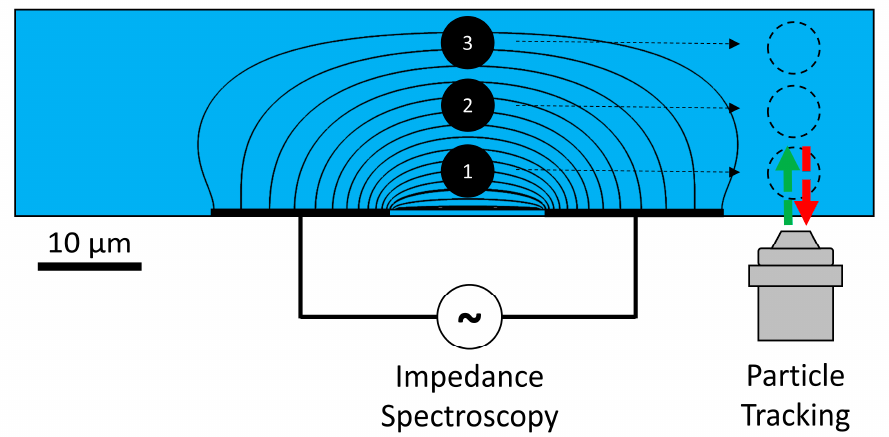
Figure 1. Coplanar electrode setup illustrating the inhomogeneous electric field. Passing particles in laminar flow at the bottom, middle, and top of the channel will all result in different impedance changes, owing to the inhomogeneity. Independent optical verification of the particle height is performed using general defocusing particle tracking (GDPT).